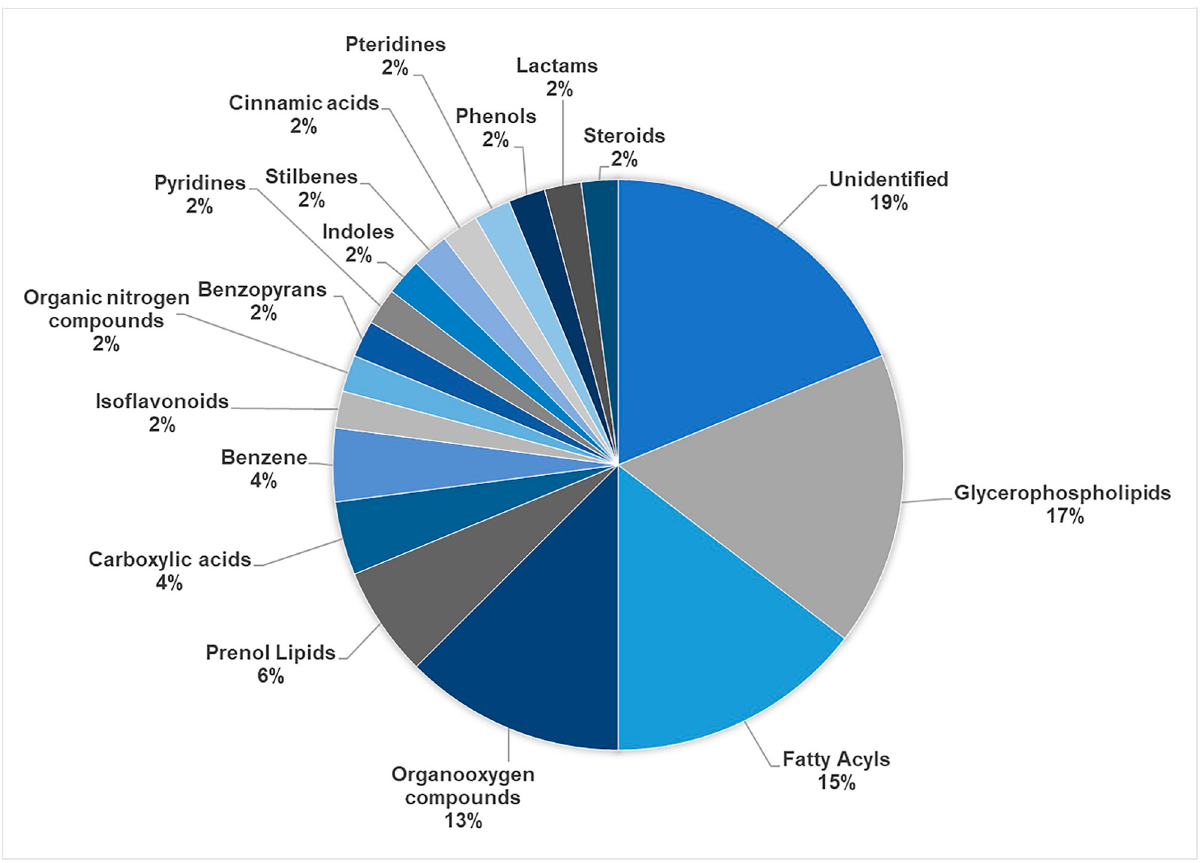
Fig 5. Classes of the metabolites identified in the